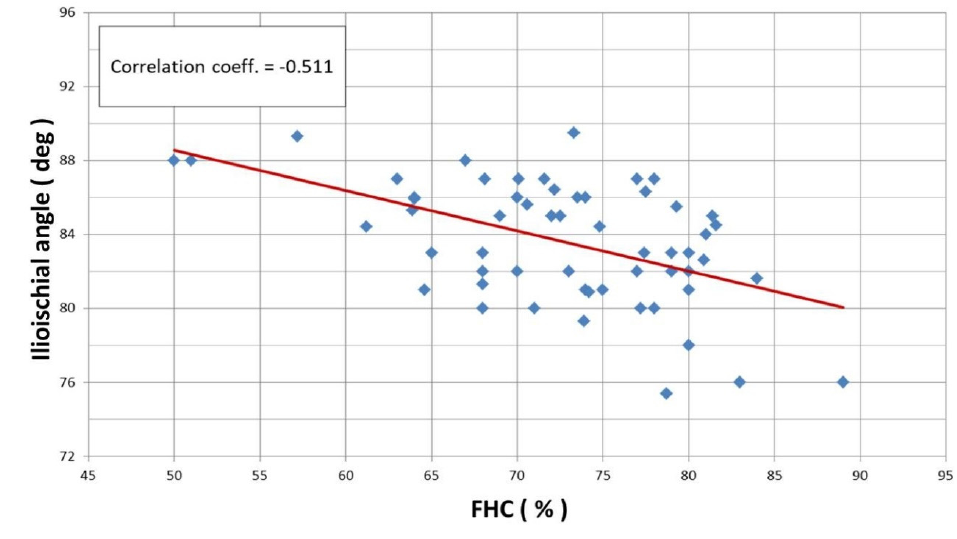
Figure 5. Linear correlation according to Pearson for ilioischial angle and FHC index (r = − 0.511). A normal distribution according to Shapiro–Wilk was obtained for all scale scores, and parametric statistical tests were applied. A statistically significant ( p < 0.05) difference pre ‐ and postoperatively was observed for all outcomes. The HHS increased by a mean of 22 points (range: 15.8 to 28.2) and the M. Postel–d’Aubigne score by a mean of 3.5 points (range: 2.0 to 4.4), and the WOMAC decreased by a mean of 24% (range: 22.6 to 25.8). Based on the HLS test, an improvement in gluteal muscles efficiency was observed in 67% of patients postoperatively (preoperatively inefficiency seen in 75% of patients, postoperatively inefficiency in 8% of patients). This proves that this new test of gluteal muscle efficiency, i.e., the HLS test, has excellent clinical value (Table 2). ROC curves were analyzed using statistically significant correlations of linear radiological measurements (CEA, FHC, and ilioischial angle) before and after PAO. Assuming that a good clinical score represents an improvement in clinical scales (HHS, WOMAC, Postel), an optimal clinical score is an improvement by more than the group scale means an improvement of more than 22 points, more than 24 points for the WOMAC scale, and more than 3.5 points for the M. Postel–d’Aubigne scale. The obtained results of